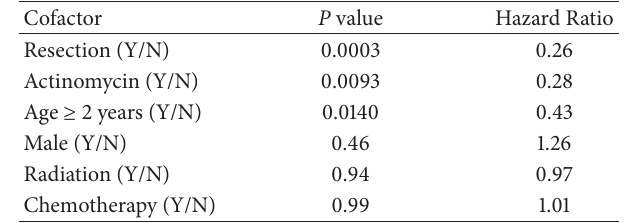
Table 2: Results of Cox regression of overall survival on six